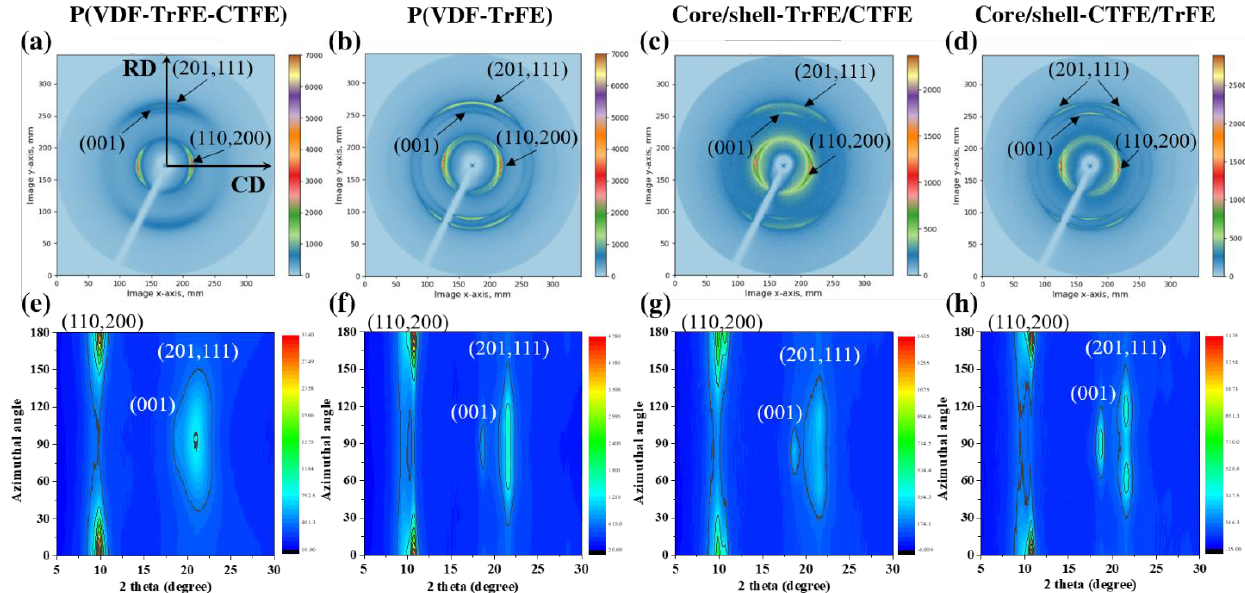
Figure 5. The 2D WAXD patterns in the ( a ) P(VDF-TrFE-CTFE), ( b ) P(VDF-TrFE), ( c ) core/shell-TrFE/CTFE, and ( d ) core/shell-CTFE/TrFE. Azimuthal profiles as a function of the 2 θ angle in the ( e ) P(VDF-TrFE-CTFE), ( f ) P(VDF-TrFE), ( g ) core/shell-TrFE/CTFE, and ( h ) core/shell-CTFE/TrFE.